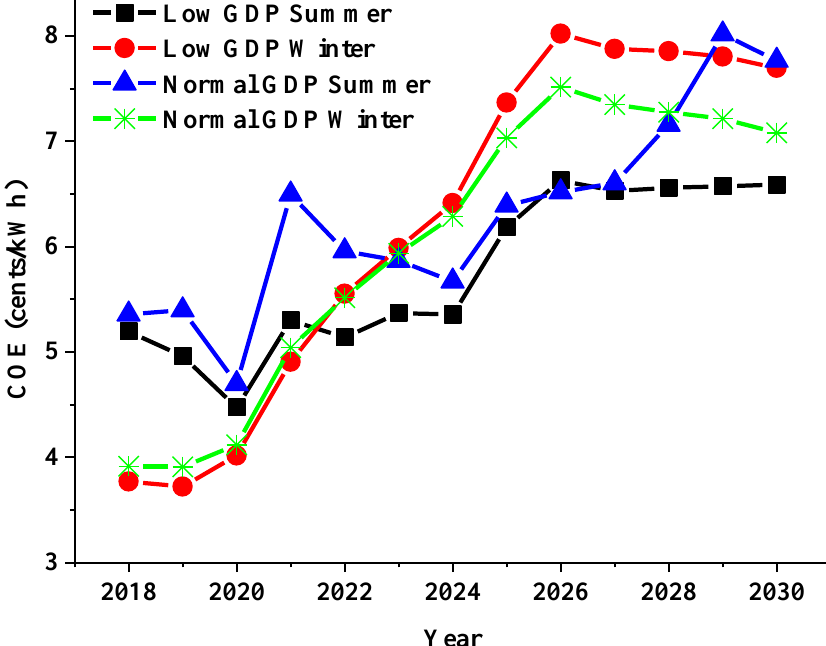
Figure 7. Cost of electricity for the reference case.